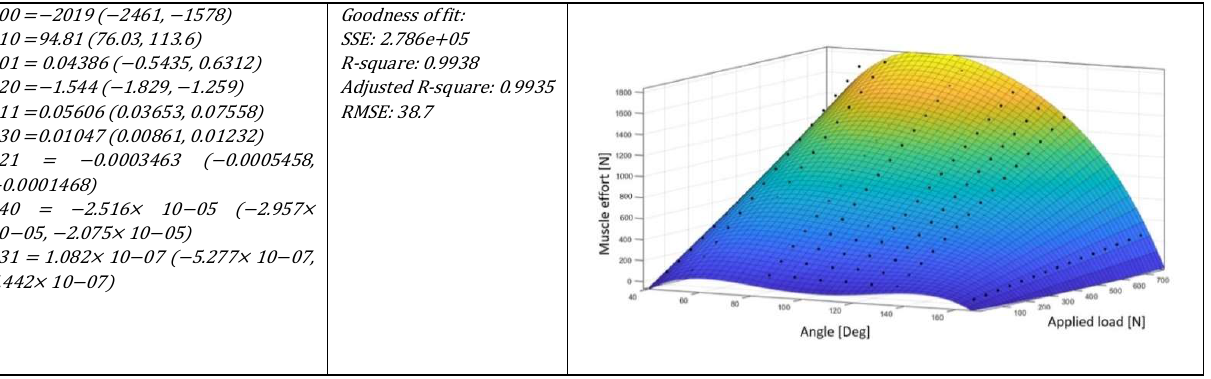
Figure 17. General formulation of lateral triceps efforts based on wrist load on the wrist (W) and elbow angle ( α ) and surface reconstruction of the proposed polynomial. p00 = −13.56 (−161.9, 134.8) p10 = 0.6366 (−5.664, 6.937) p01 = −0.2656 (−0.4622, −0.06901) p20 = −0.01038 (−0.1059, 0.08512) p11 = 0.06707 (0.06053, 0.0736) p30 = 7.035× 10−05 (−0.000551, 0.0006917) p21 = −0.0004743 (−0.000541, −0.0004075) p40 = −1.691× 10−07 (−1.645× 10−06, 1.306× 10−06) p31 = 5.439× 10−07 (3.31× 10−07, 7.568× 10−07) Goodness of fit: SSE: 3.122e+04 R-square: 0.9993 Adjusted R-square: 0.9992 RMSE: 12.96 Figure 18. General formulation of long triceps efforts based on wrist load (W) and elbow angle ( α ) and surface reconstruction of the proposed polynomial.